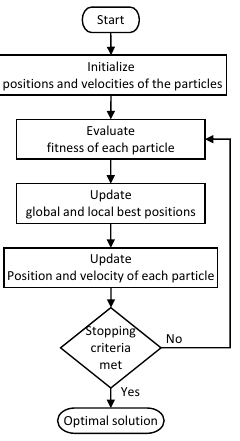
Figure 5. Flow of the PSO